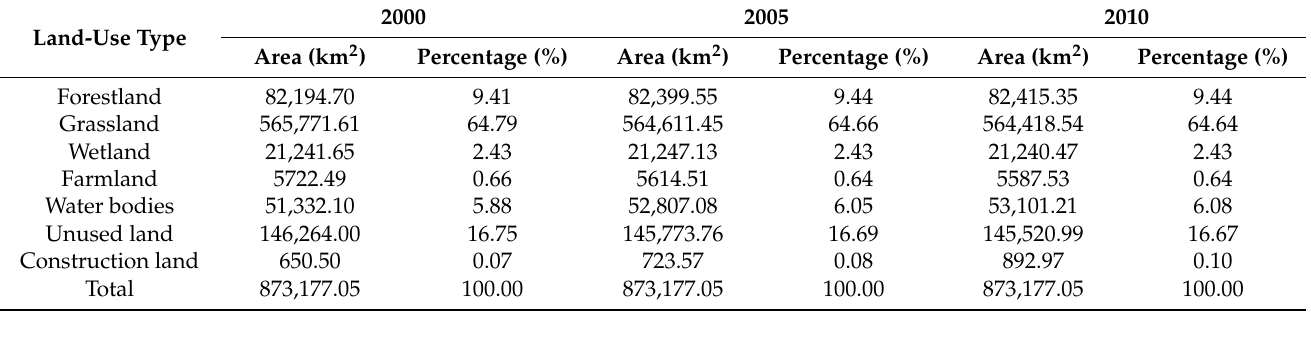
Table 3. Land-use dynamics in the national nature reserves of western China.